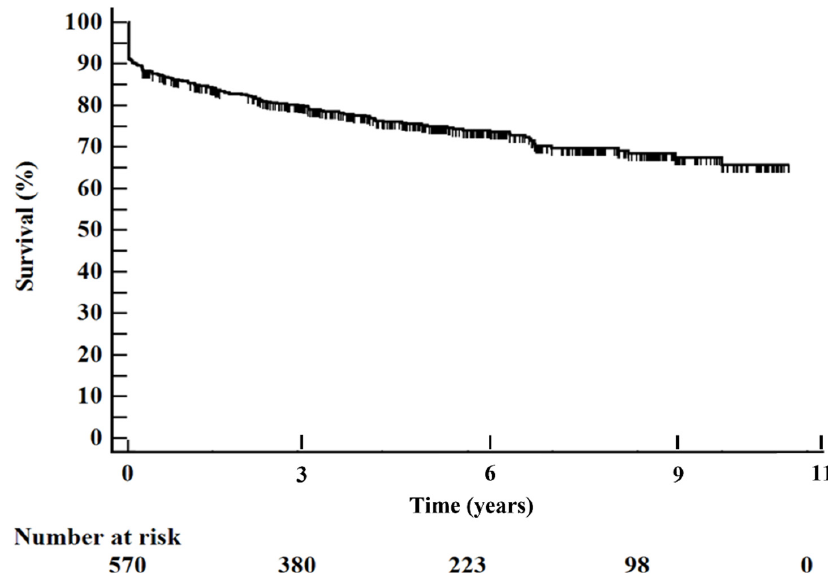
Figure 1. Overall survival at maximum follow ‐ up in the total cohort of patients. As previously reported in Table 1, non ‐ surviving patients ( n = 161) were older (77.5 +/ − 10.8 vs. 62.5 +/ − 12.2 years old), female (43.2% vs. 34.4%), anemic (26.4% vs. 18.2%) and had an impaired renal function at the baseline (eGFR ≤ 30 mL/min/m 2 in 13.3% vs. 2%). Moreover, a higher Killip class ( ≥ 3 in 32.4% vs. 4.3%) and cardiogenic shock (20.9% vs. 1.7%) at admission were more often represented. At coronary angiography three vessel disease (26.3% vs. 11.6%), left main involvement (10.5% vs. 0.2%) and the need for IABP support (13.5% vs. 1.9%) with the more frequent femoral approach (74.3% vs. 52.6%) in